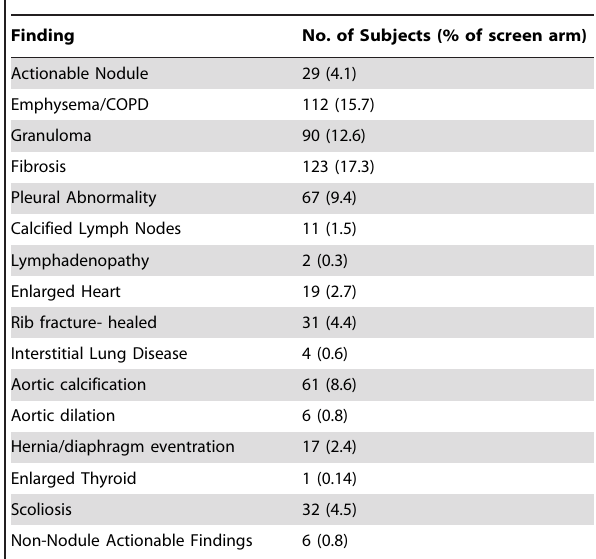
Table 3. Baseline findings from the CXRs of the screened